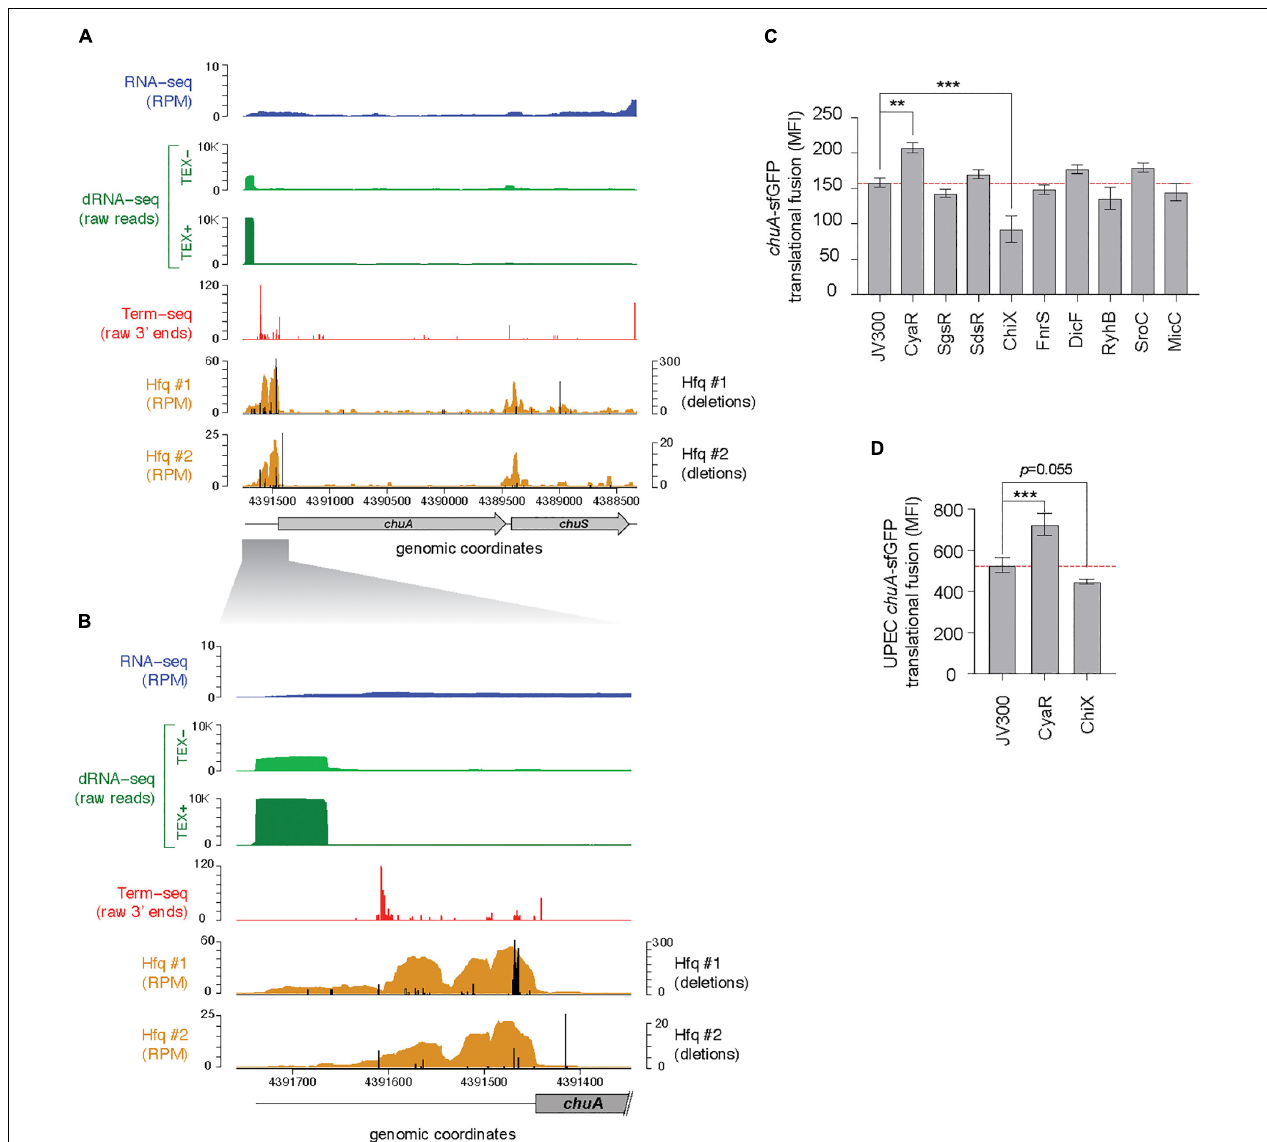
FIGURE 1 | The chuA 5 (cid:48) UTR is regulated by Hfq-dependent small RNAs. (A) RNA-sequencing data mapping to the chuAS operon. From top to bottom: total RNA-seq (dark blue; RPM), differential RNA-seq in samples untreated (light green) and treated (dark green) with TEX, Term-seq (red; raw 3 (cid:48) end reads) (BioProject PRJNA601151), Hfq-binding sites from UV-crosslinking datasets (BioProject PRJNA197291). Sequencing deletions which indicate direct contact with Hfq are indicated in black. (B) Same as (A) , but focusing on the 5 (cid:48) UTR of chuA. (C) Fluorescence measurements of the EHEC chuA- sfGFP fusion in the presence of predicted binding sRNAs. (D) Fluorescence measurements of the UPEC chuA- sfGFP fusion in the presence of CyaR or ChiX (*** p < 0.001, **p <